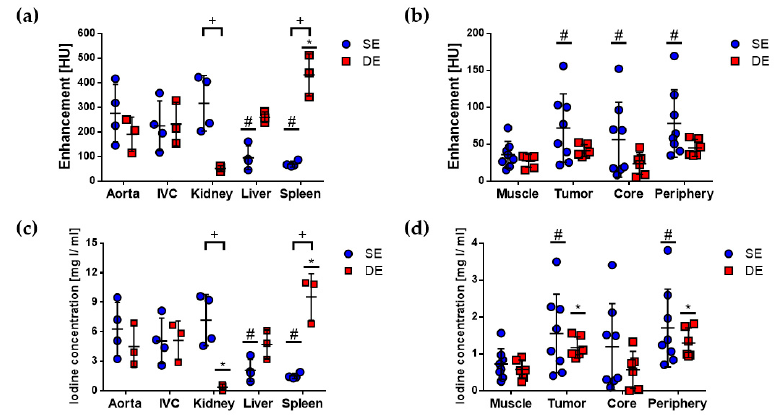
Figure 3. Quantitative evaluation of enhancement (E) and C I in SE and DE micro-CT images of the subcutaneous C6 glioma model. Mean and standard deviation are shown in scatter plots to compare E in ( a ) aorta, IVC, kidney, liver, and spleen and ( b ) muscle and tumor regions: complete tumor (tumor), central tumor (core), and peripheral tumor (periphery), quantified in SE and DE subtracted images. Mean and standard deviation are shown in scatter dot plots to compare C I in ( c ) aorta, IVC, kidney, liver, and spleen and ( d ) muscle and tumor regions, quantified in SE and DE subtracted images. Statistically significant differences ( p < 0.05) were evaluated with two-way ANOVA and Bonferroni’s multiple comparisons test and are indicated for each comparison: (+) SE vs. DE, for all VOIs; (#) aorta (or muscle) vs. VOIs in SE images; (*) aorta (or muscle) vs. VOIs in DE images. E and C I mean values were significantly different between the aorta and liver and spleen in SE images, as indicated by (#), and between the aorta and spleen in DE images, as indicated by (*), in Figure 3a,c. C I in the aorta was also significantly different from C I in the kidney in DE images. It can be observed that there were marked differences in E and C I values in the aorta among the different